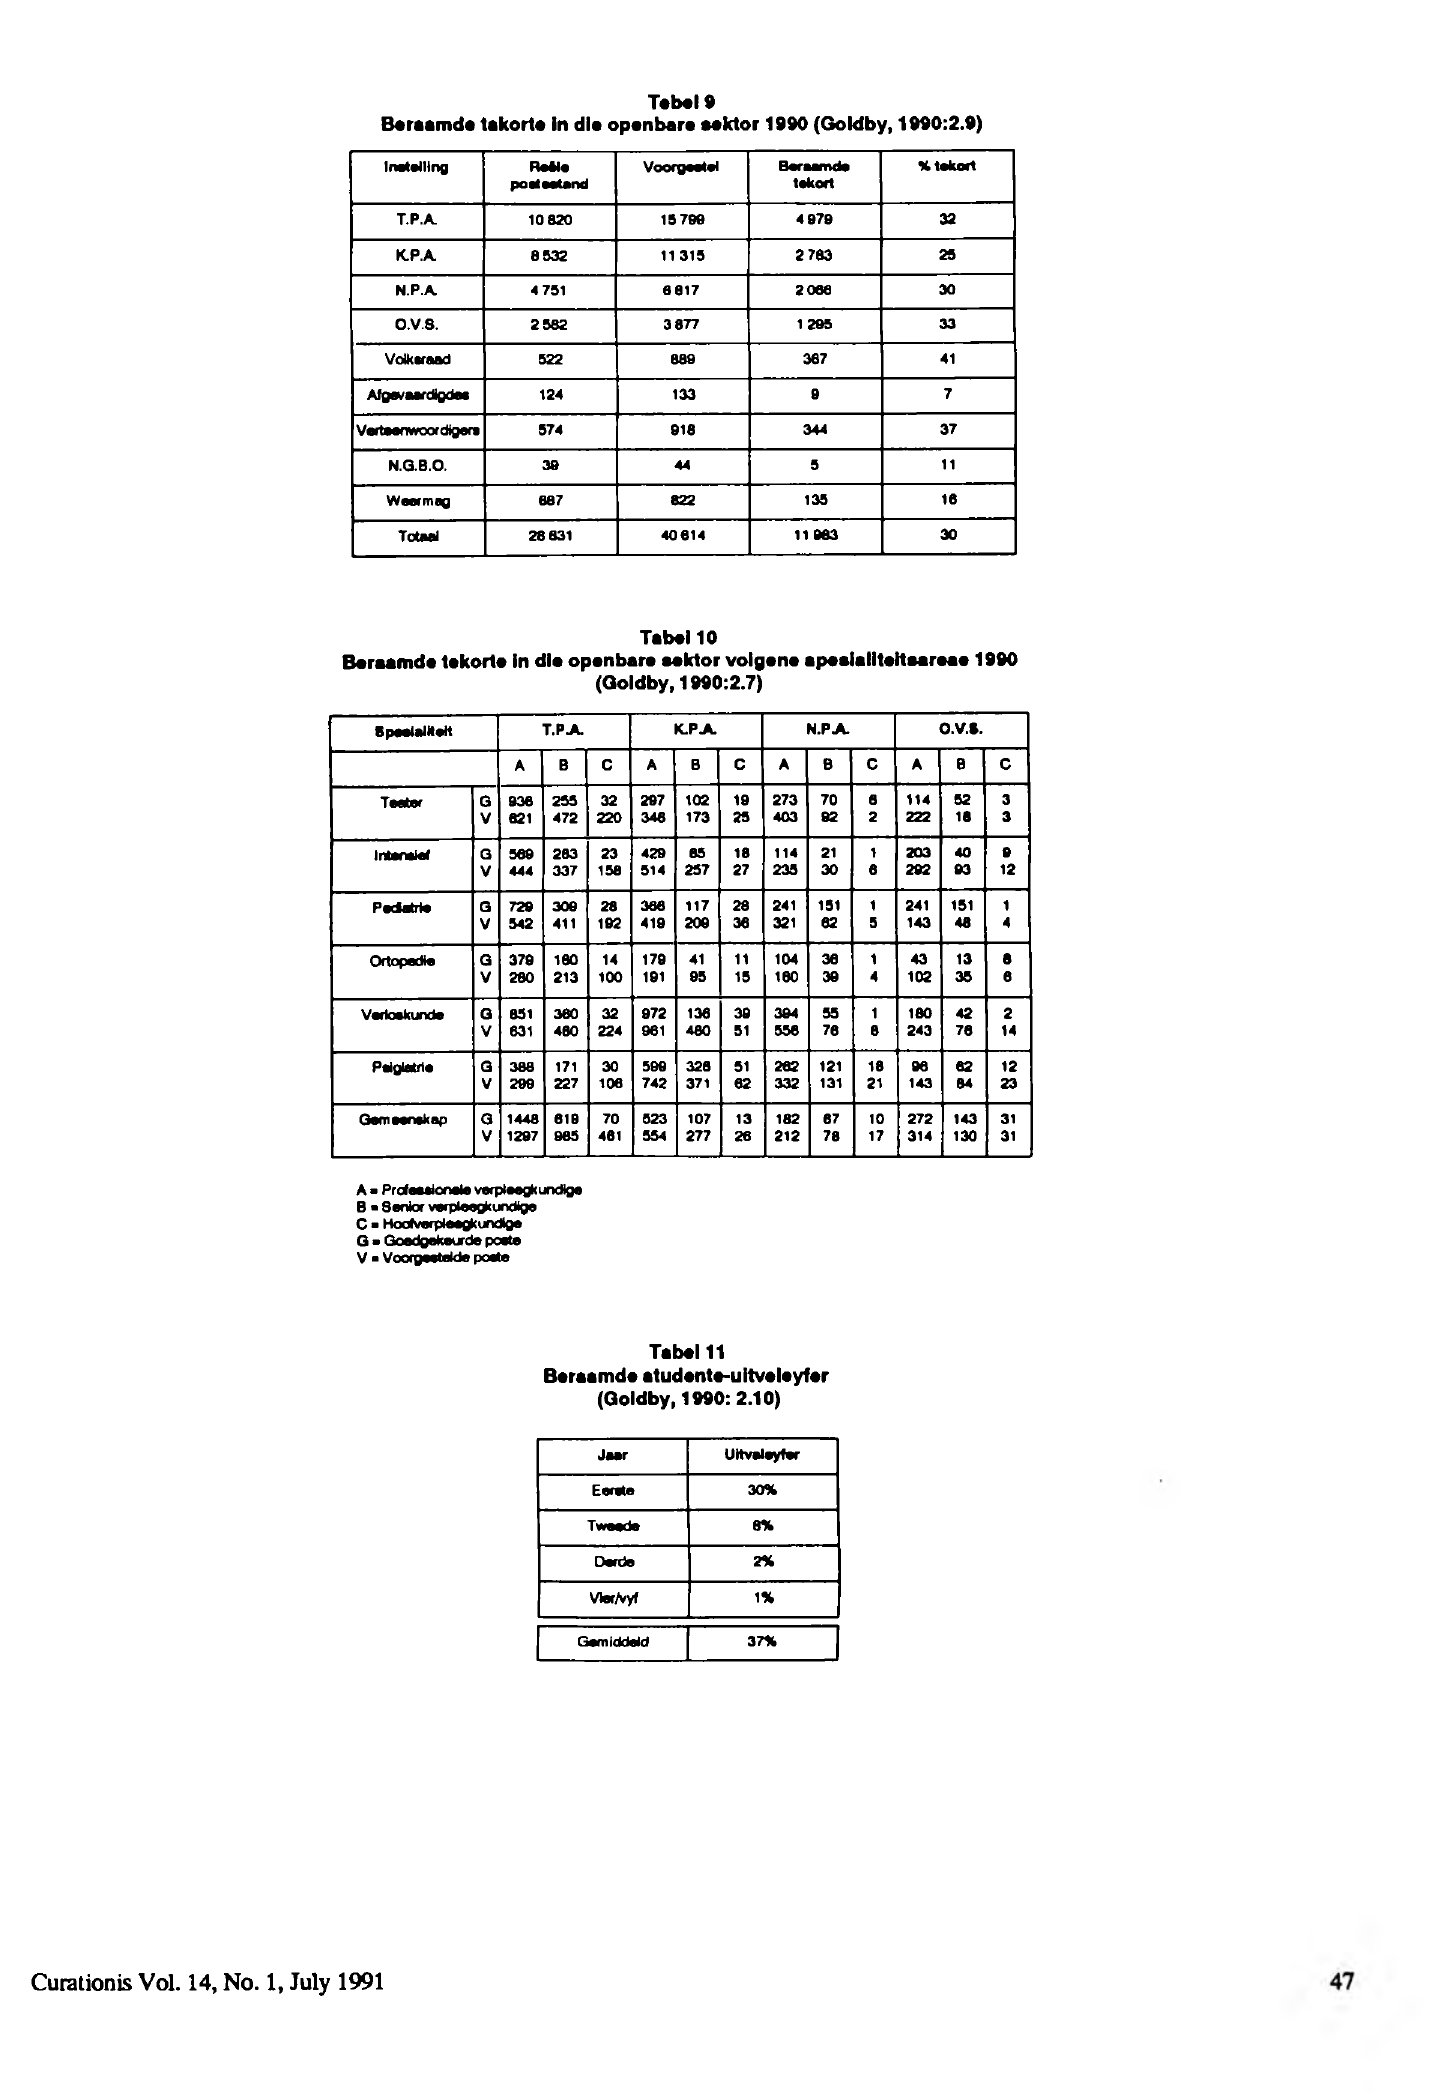
TabaMO Baraamda takorta In dla opanbara aaktor volgana apaalalltaltaaraaa 1990 (Qoldby, 1990:2.7)